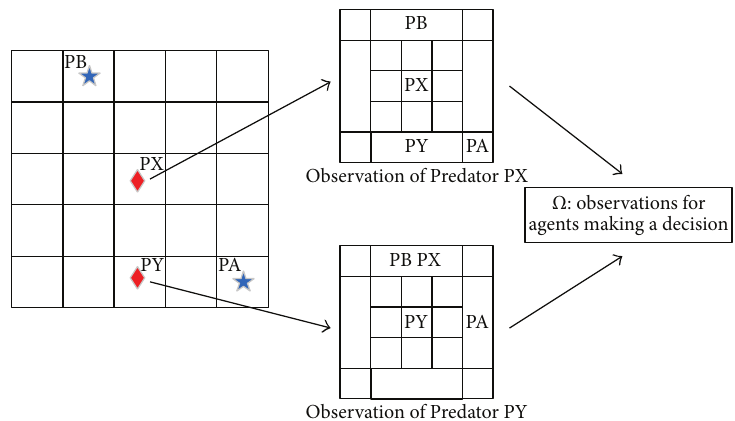
Figure 2: The grid-based map in the predator-prey